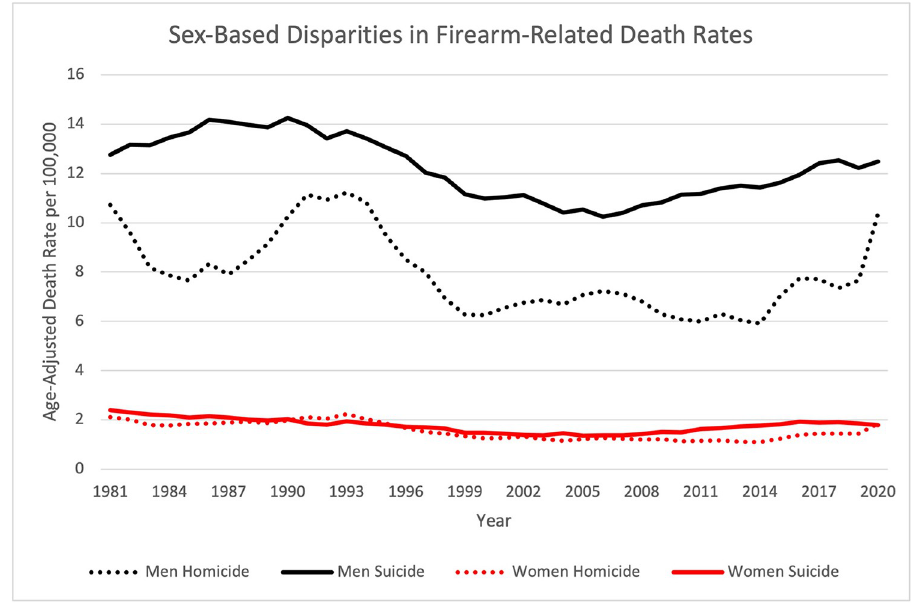
Fig 3. Yearly firearm-related age-adjusted death rates by sex. Age-adjusted death rates per 100,000 for firearm- related deaths by sex from 1981 to 2020.